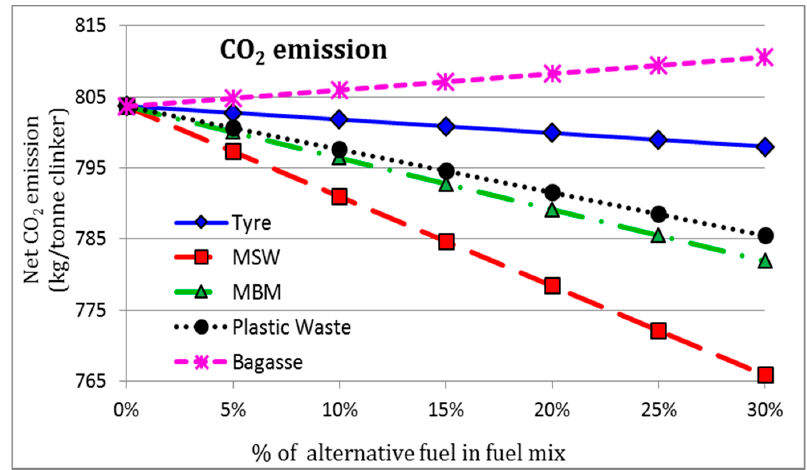
Figure 4. Net CO 2 emission (kg/tonne clinker).